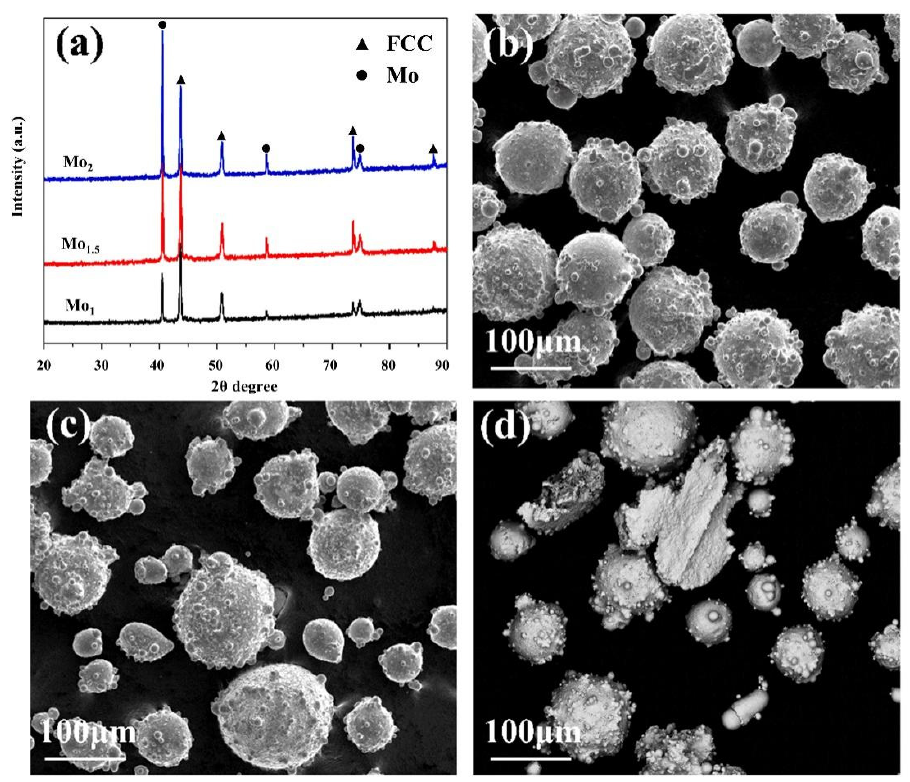
Figure 4. ( a ) XRD patterns of the ((CoCrFeNi) 95 Nb 5 ) 100-x Mo x (x = 1, 1.5, 2) HEA powder; ( b – d ) SEM images of the ((CoCrFeNi) 95 Nb 5 ) 100-x Mo x (x = 1, 1.5, 2) HEA powder, where ( b ) x = 1, ( c ) x = 1.5, ( d ) x = 2.